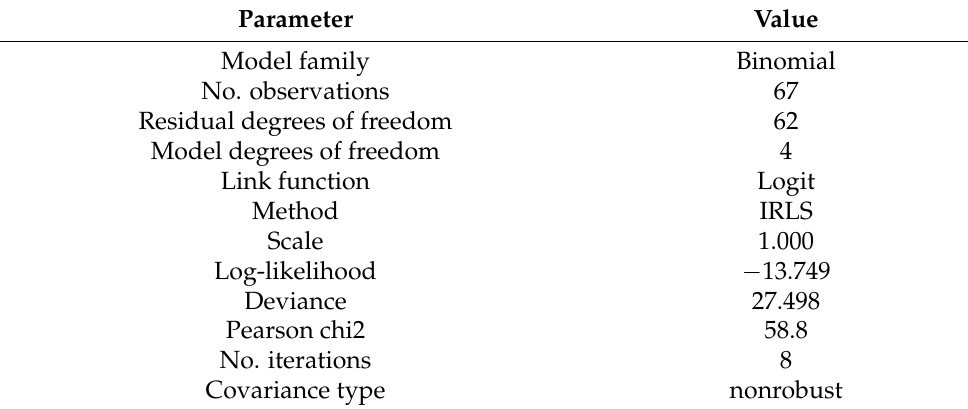
Table 4. Detailed information about the model separating the HD-D and HD-A groups.